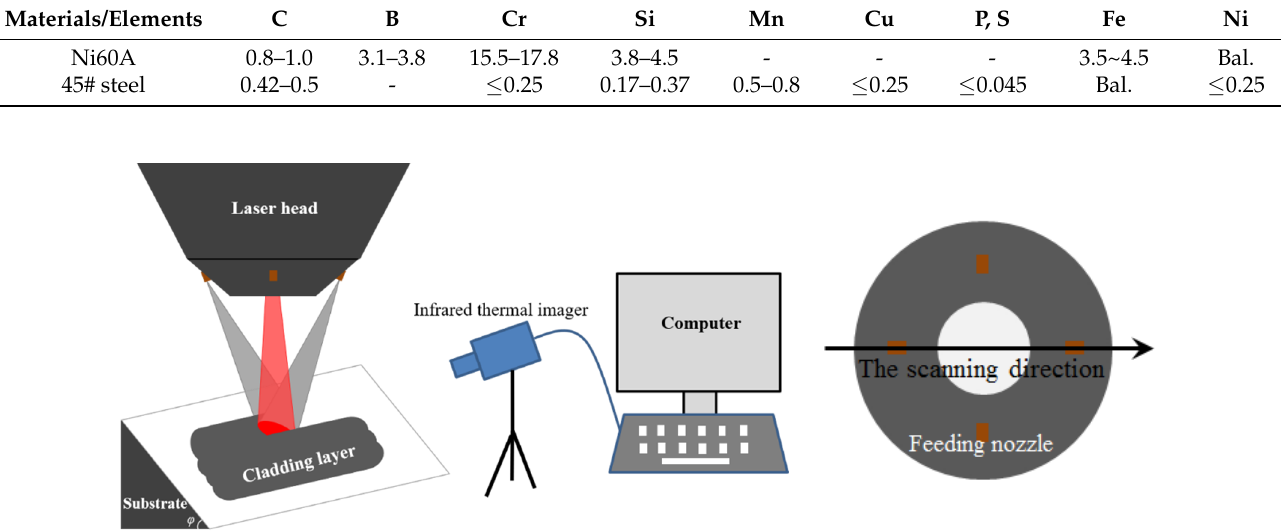
Figure 1. Schematic diagram of the laser cladding process on tilted substrate. After laser cladding, the surface cracks of Ni60A coating are characterized by dye penetration test. The cracking rate R c (N/mm) is assessed via the crack number (N) in unit cladding length (mm), i.e., the ratio of the total crack number to the total length